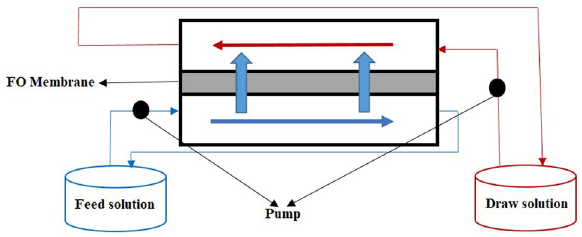
Figure 2. Schematic of the used forward osmosis